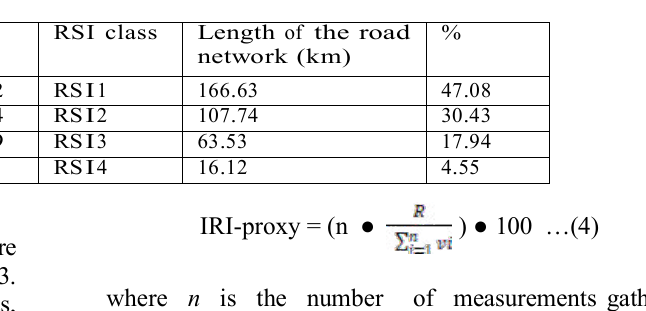
Table 2. Four levels of road surface condition based on IRI.